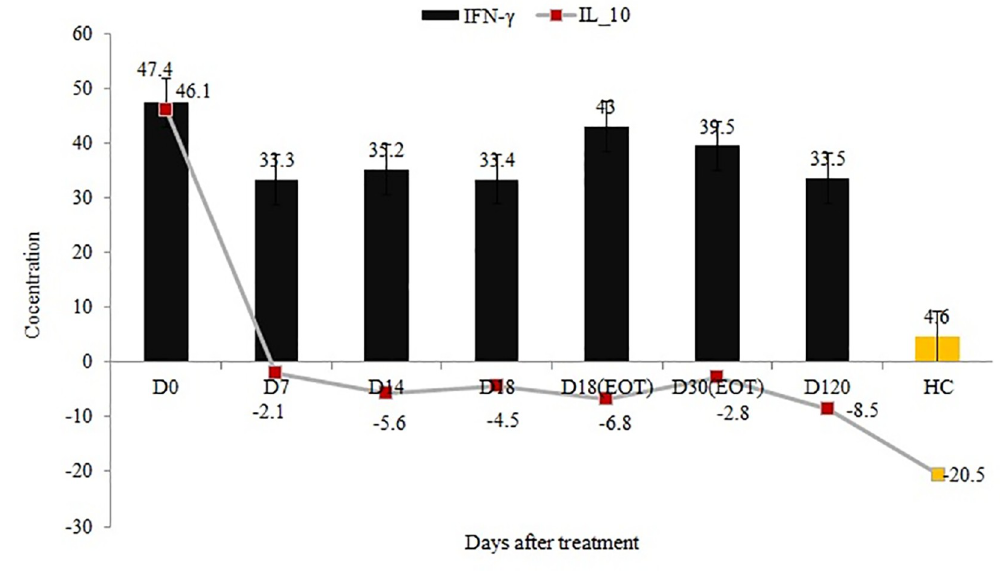
Fig 4. IFN- γ gamma and IL-10 serum cytokine concentrations in VL patients before and after treatment cf. concentrations in healthy controls. IL-2. Lower (below detection limits) concentrations of IL-2 at day 0 (median concentra- tion of -1.8 pg/ml; IQ range -3.4 − 3.2 pg/ml) were measured in serum samples of 48 VL pati-